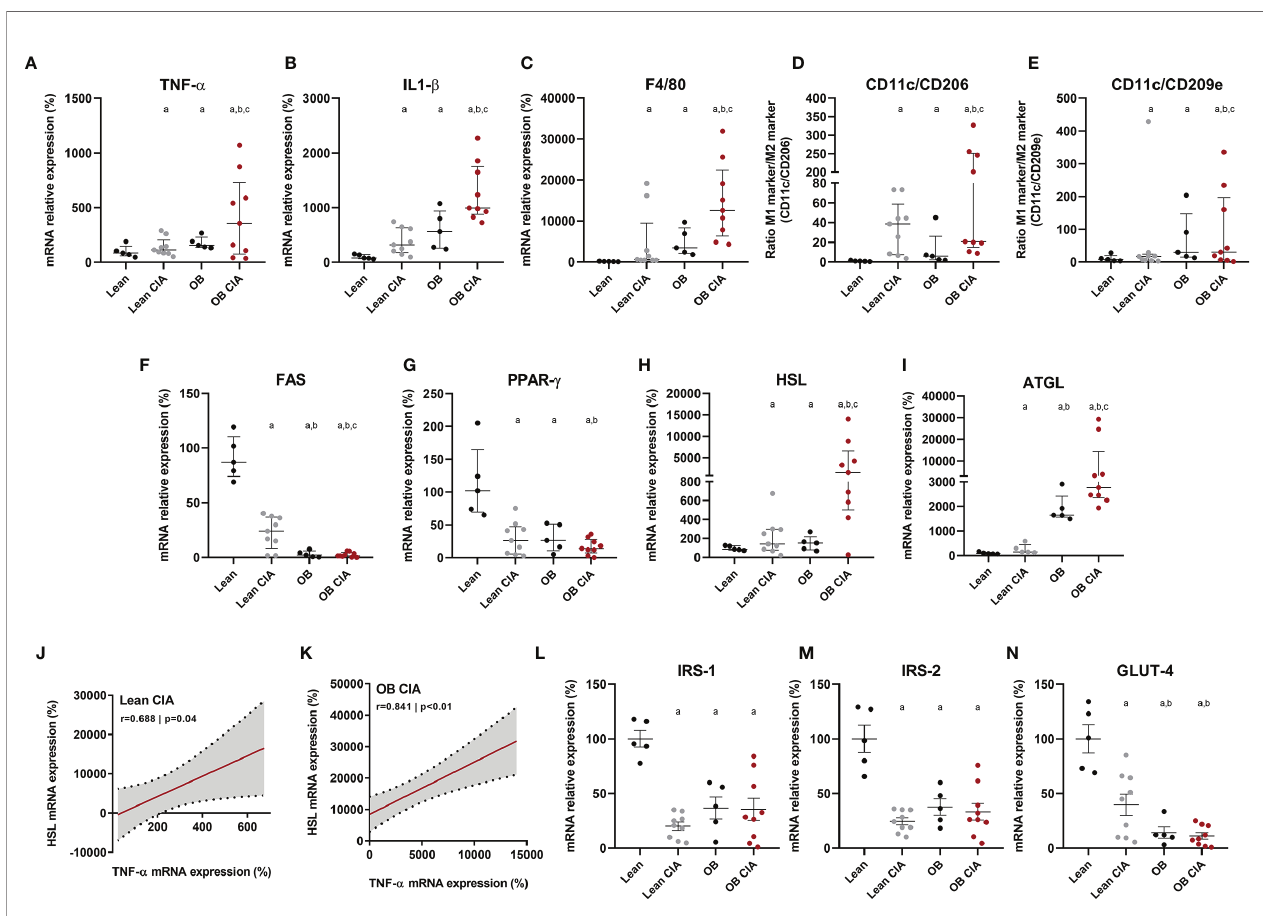
FIGURE 2 | In fl ammatory and metabolic pro fi le in adipose tissue of OB CIA mice. In fl ammation, presence and polarization of macrophages, and glucose and lipid metabolisms. (A) mRNA relative expression of TNF- a in white adipose tissue of control lean, Lean CIA, OB, and OB CIA, (B) mRNA relative expression of IL-1 b white adipose tissue of control lean, Lean CIA, OB, and OB CIA, (C) mRNA relative expression of F4/80 in white adipose tissue of control lean, Lean CIA, OB, and OB CIA, (D) ratio of CD11c/CD206 mRNA relative expression in white adipose tissue of control lean, Lean CIA, OB, and OB CIA, (E) ratio of CD11c/CD209e mRNA relative expression in white adipose tissue of control lean, Lean CIA, OB, and OB CIA, (F) mRNA relative expression of FAS in white adipose tissue of control lean, Lean CIA, OB, and OB CIA, (G) mRNA relative expression of PPAR g in white adipose tissue of control lean, Lean CIA, OB, and OB CIA, (H) mRNA relative expression of HSL in white adipose tissue of control lean, Lean CIA, OB, and OB CIA, (I) mRNA relative expression of ATGL in white adipose tissue of control lean, Lean CIA, OB, and OB CIA, (J) correlation between the mRNA expression of HSL and TNF- a in white adipose tissue of lean CIA, (K) correlation between the mRNA expression of HSL and TNF- a in white adipose tissue of OB CIA, (L) mRNA relative expression of IRS-1 in white adipose tissue of control lean, Lean CIA, OB, and OB CIA, (M) mRNA relative expression of IRS-2 in white adipose tissue of control lean, Lean CIA, OB, and OB CIA, and (N) mRNA relative expression of GLUT-4 in white adipose tissue of control lean, Lean CIA, OB, and OB CIA. CIA, collagen induced arthritis; OB, obese; TNF- a , tumor necrosis factor alpha; IL-1 b , interleukin 1 beta; F4/80, cell surface glycoprotein F4/80; CD, cluster differentiation; FAS, fatty acid synthase; PPAR g , Peroxisome Proliferator Activated Receptor Gamma; HSL, hormone sensitive lipase; ATGL, adipose triglyceride lipase; IRS-1, insulin receptor substrate 1; GLUT-4, glucose transporter type 4. Signi fi cance was determined by one-way ANOVA followed by Ducan post hoc test (A – I, L – N) . a Signi fi cant differences vs. lean (p < 0.05). b Signi fi cant differences vs. lean CIA (p < 0.05). c Signi fi cant differences vs. OB (p <